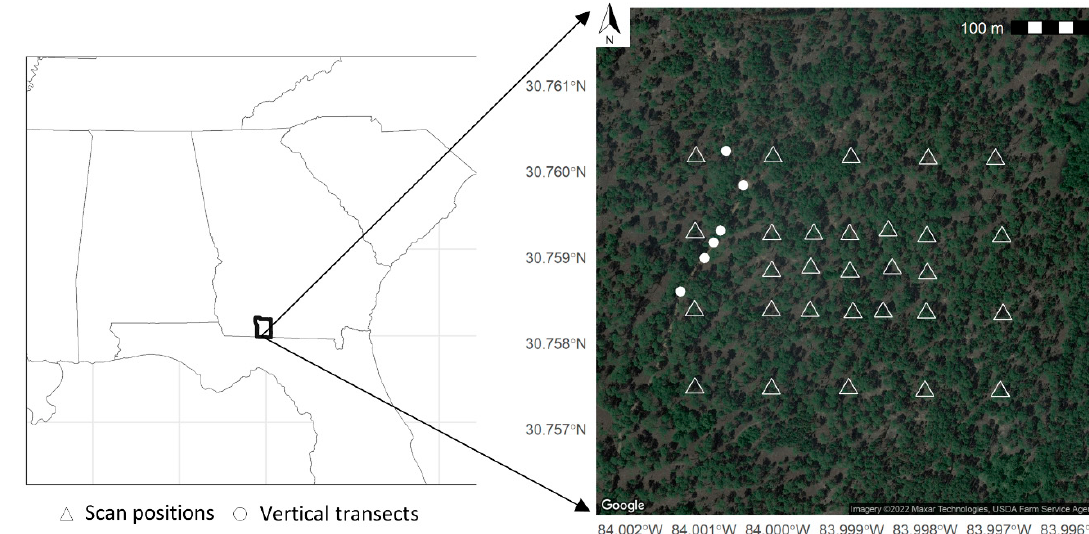
Figure 1. Location of the study area within Thomas County, GA (inset), terrestrial laser scanning positions (triangles), and digital hemispherical photographs acquired at vertical transects (circles). Satellite imagery was obtained using Google Earth API and the R package ggmap [43], state and county boundaries were obtained from the US Census Bureau using the R package tigris [44].